Question: Provide a one-line summary of what is displayed.
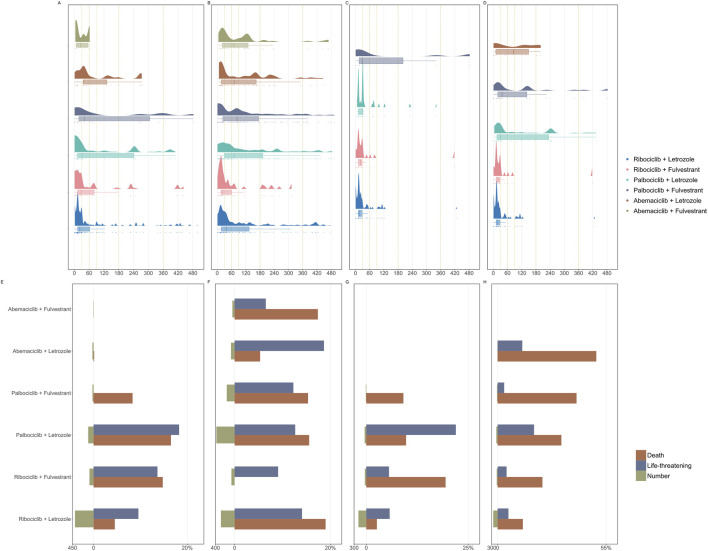
Answer: Cloud and rain plots illustrating the onset timing of cardiovascular adverse reactions across distinct combination regimens. (A,E) show cardiac arrhythmias; (B,F) represent embolic and thrombotic events; (C,G) indicate QT prolongation; (D,H) correspond to shock. The bar graphs below present outcome indicators for cardiovascular adverse events related to these combination therapies.